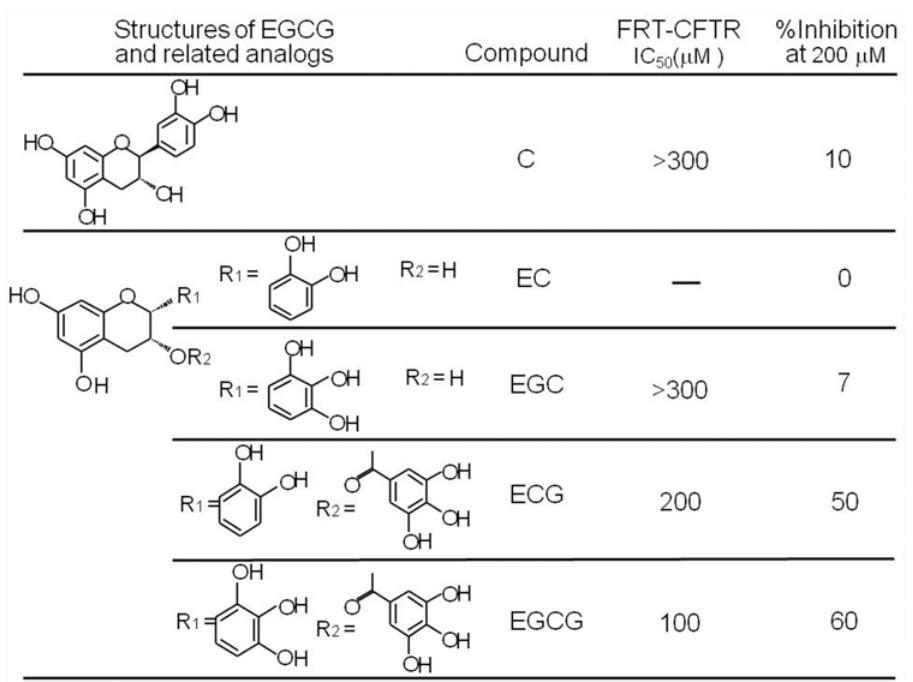
Fig 4. Structure-activity analysis of catechin analogs. IC 50 was determined from concentration-inhibition data from cell-based fluorescence measurements.